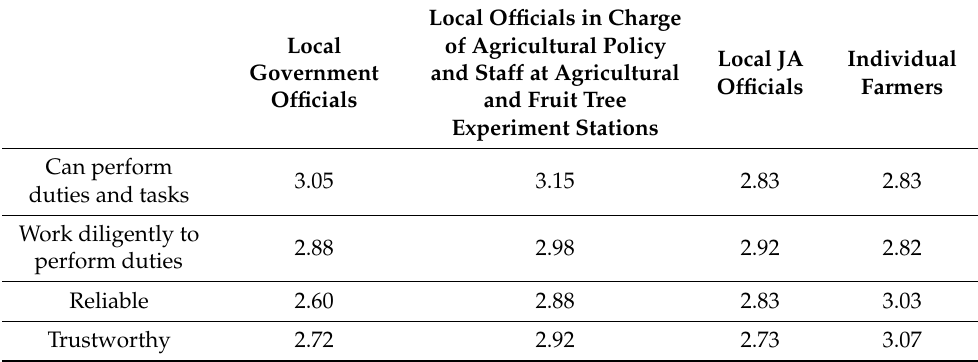
Table 9. Trust in primary actors involved in agricultural policy and climate change adaptation policies in agriculture and rural